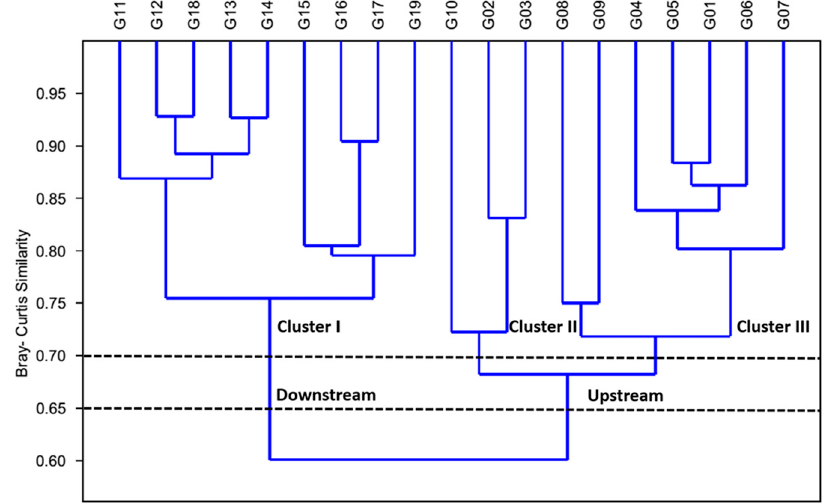
Figure 13. Cluster analysis of the Geum River watershed based on water quality factors and fish guilds.